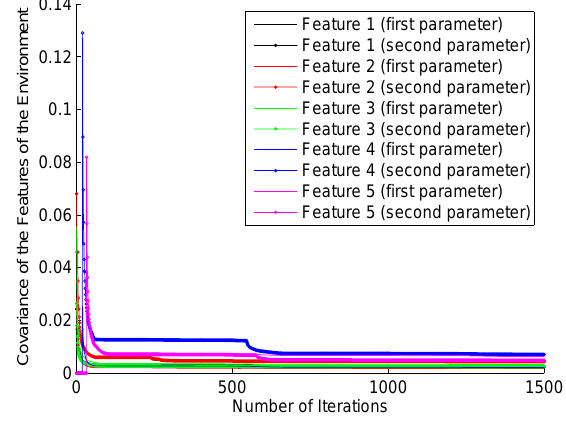
Covariance evolution of a same set of features of Figure 12 estimated by EKF-SLAM with the sum of eigenvalues feature selection approach.